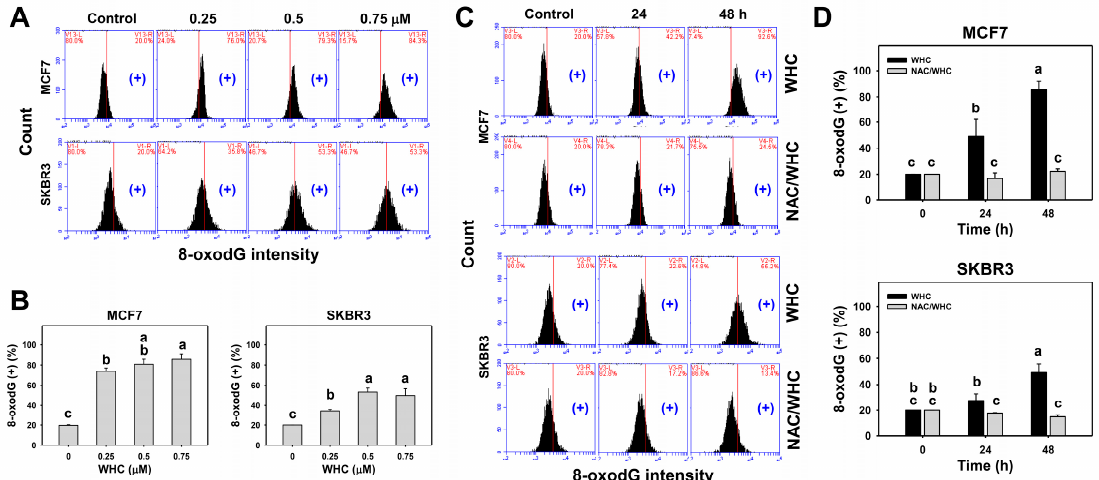
Figure 7. WHC differentially induced oxidative DNA damage (8-oxodG) of breast cancer cells. ( A , B ) 8-oxodG profiles and statistics for dose effects of WHC. Breast cancer (MCF7 and SKBR3) cells were treated with WHC (control (0.075% DMSO), 0.25, 0.5, and 0.75 µ M) for 48 h. ( + ) located on the right side of each profile is counted for 8-oxodG ( + ) (%). ( C , D ) NAC pretreatments reversed the WHC induced 8-oxodG generation. Following pretreatments with NAC (10 mM for 1 h), cells were treated with control (0.075% DMSO) and 0.75 µ M of WHC for 0, 24, and 48 h, i.e., NAC / WHC. Data are means ± SDs ( n = 3). Results marked without overlapping letters show significant differences ( p < 0.05 to 0.0001).